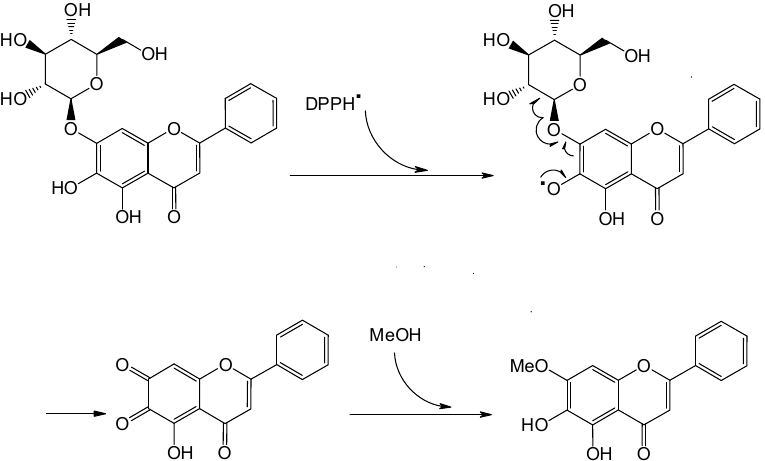
Figure 4. Plausible reaction route of flavonoid glycosides with DPPH, using baicalein-7- O -glucoside as an example. as an